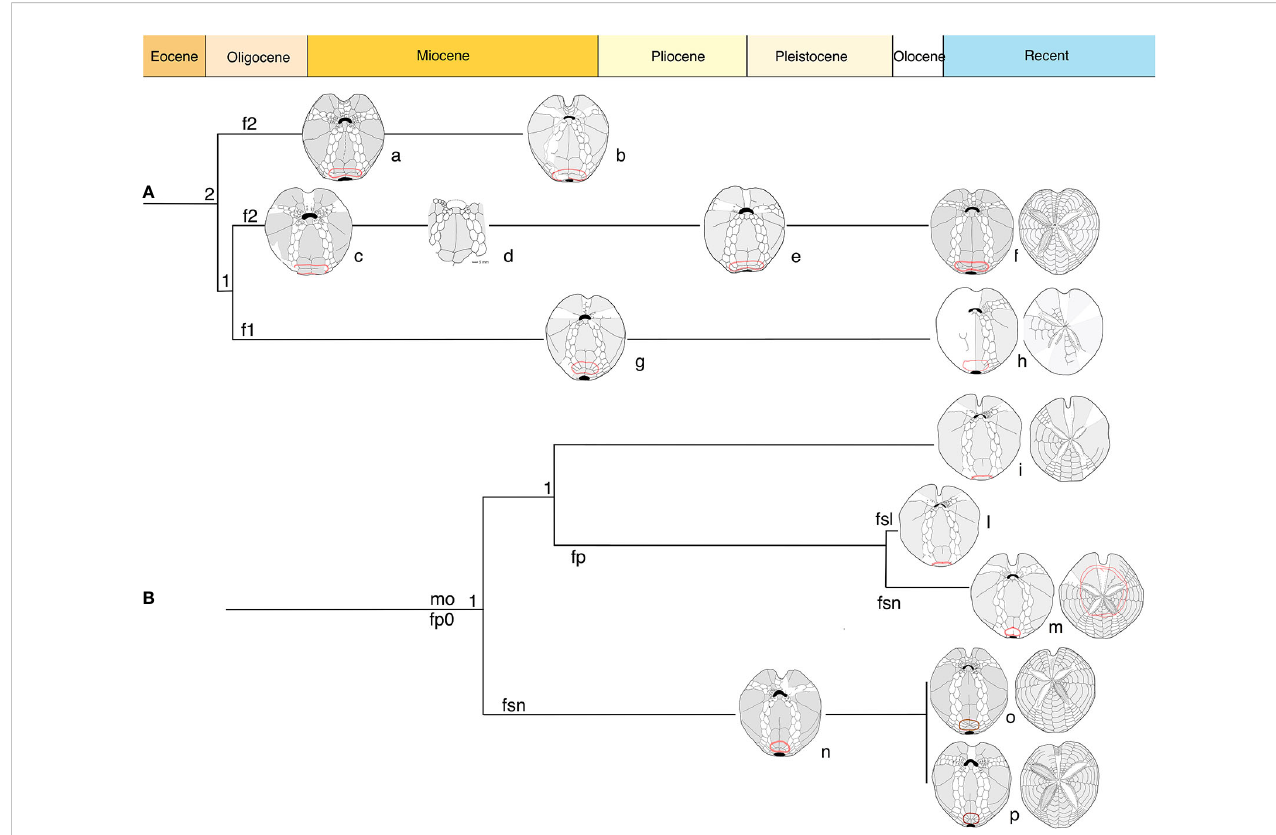
FIGURE 9 Diagram based on structural characters in adoral schemes. (A) Clade Spatangus / Sardospatangu s; (B) clade Propespatagus , Plethotaenia , and other spatangids. Numbers: 1 = 1 plate; 2 = 2 plates per side of labrum. Letters: f1, f2 = fasciole with 1 or 2 indicating monolobed or bilobed. Other: fp = peripetal fasciole; fp0 = non- peripetal fasciole; fsl = large subanal fasciole; fsn = normal subanal fasciole. Specimens a – p, in order: Sardospatangus caschilii ; Sardospatangus saheliensis ; Spatangus desmaresti ; Spatangus sp. 2 Ukraine; Spatangus cf. purpureus ; Spatangus purpureus ; Spatangidae sp. Florida; “ Spatangus ” californicus ; “ Spatangus ” mathesoni ; Plethotaenia spatangoides ; Plethotaenia angularis ; Propespatagus subinermis ; Propespatagus sp. 1; Propespatagus raschi